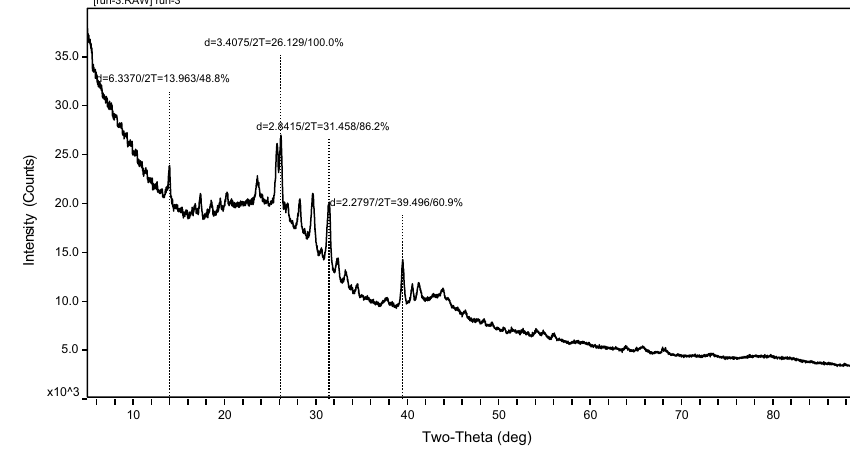
Fig. 5 Powder X-ray diffraction pattern of banana trunk-acti- vated carbon (run number 3)